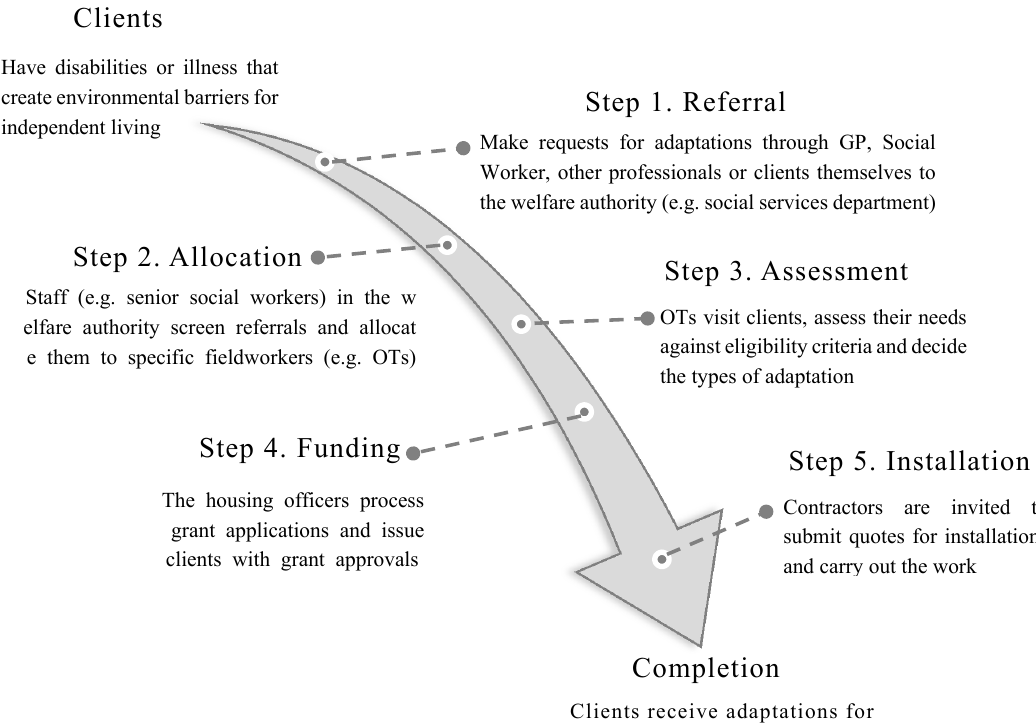
Figure 2. The pathway through the adaptation